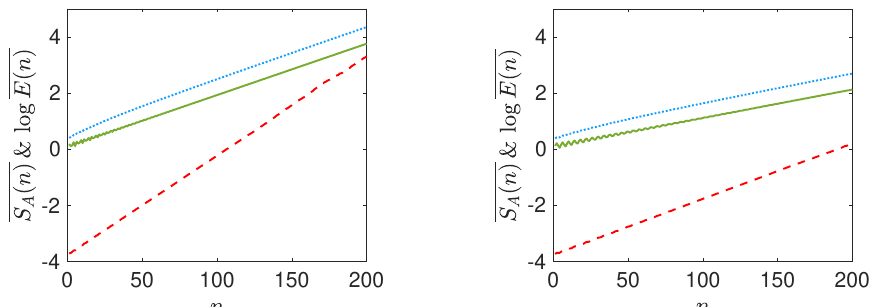
( n )) (green solid lines) A || ) n = 5 × 10 5 sample